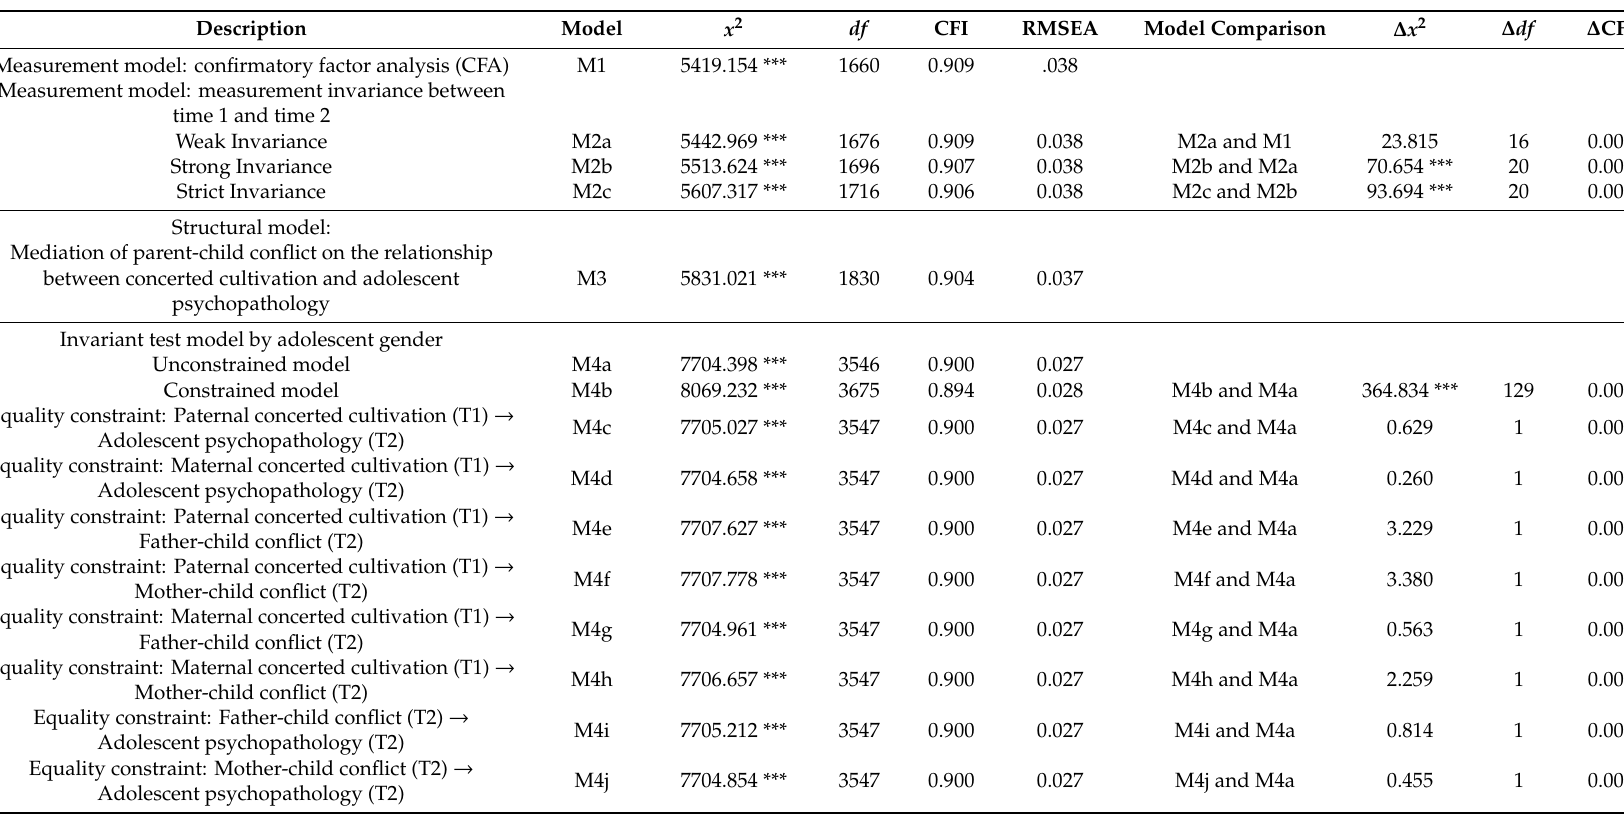
Table 3. Goodness-of-fit indicators of the measurement model, structural model and invariant test model by adolescent gender, family intactness and family economic